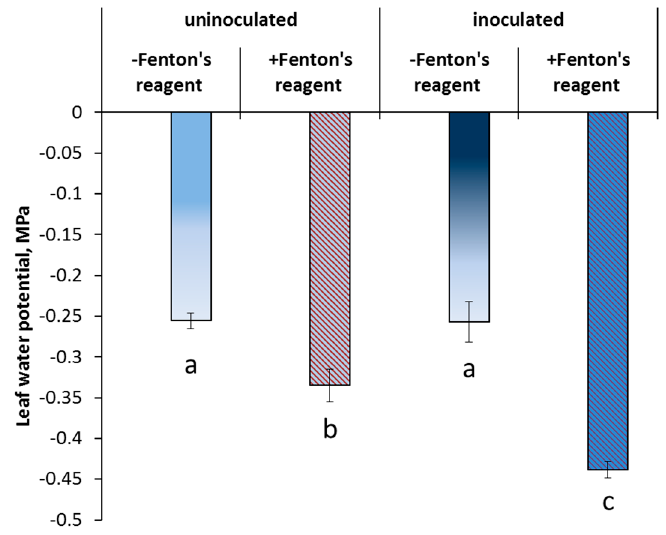
Figure 5. The effect of AQP inhibition on the leaf water potential (means ± s.e.) of control and inoculated with Pseudomonas mandelii IB-Ki14 pea plants (n = 6). Significantly different group-level means within each treatment are labeled with different letters (Duncan’s test, p ≤ 0.05).